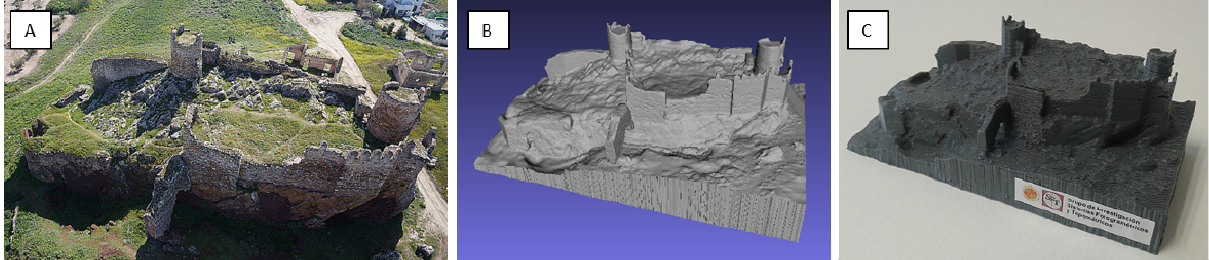
Figure 21. 3D model of the Berrueco Castle. A: aerial Sony NEX5N image from Falcon 8 flight; B: stl file format model. C: 3D plastic printed model (3D RepRap x400